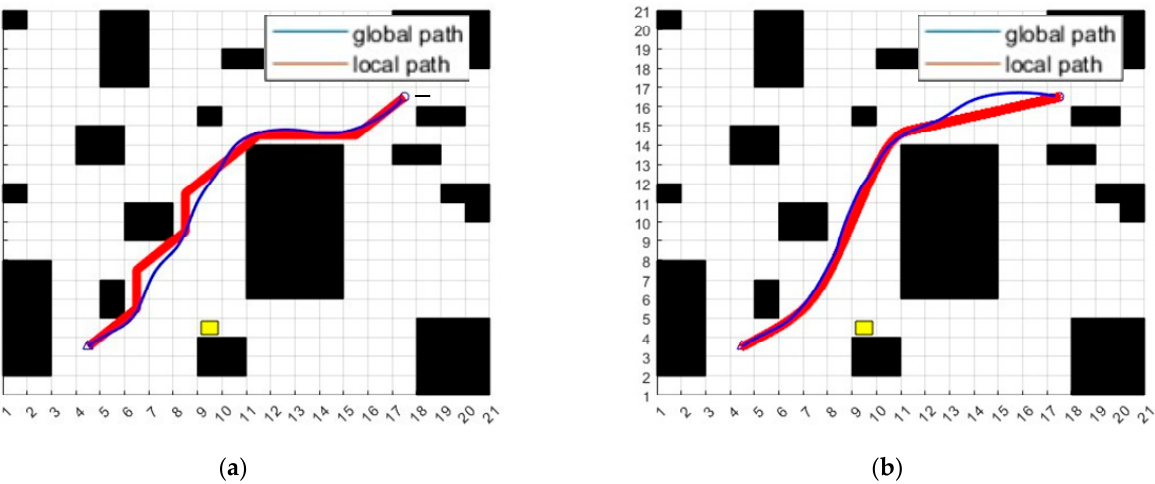
Figure 13. ( a ) Path of the hybrid algorithm of traditional A* algorithm and traditional DWA algorithm. ( b ) Path of the fusion algorithm that combines kinematical constraint A* algorithm and follows DWA algorithm.